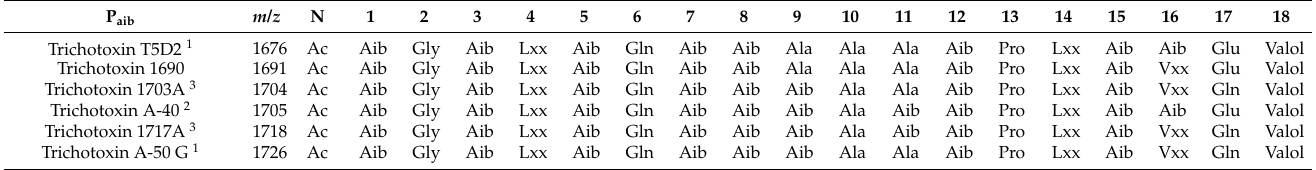
Table 5. Amino acid sequences of the P aib produced by T. asperellum . N: N-terminal modification; Ac: acetylation; Lxx: leucine/isoleucine; Vxx: